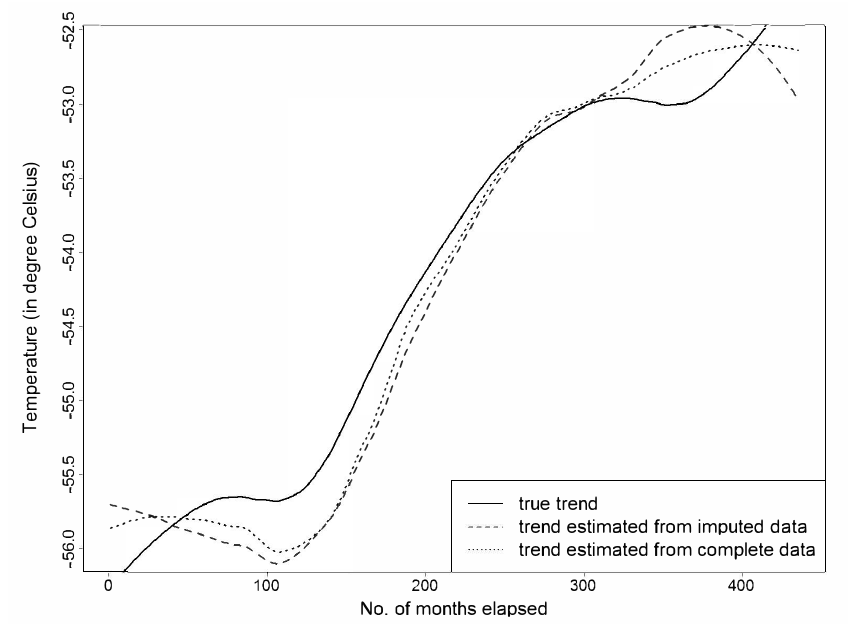
Figure 4. A comparison of the true trend and the estimated trends for a randomly simulated time series of length 498 months using Configuration 2 and with a random removal of 40% data.